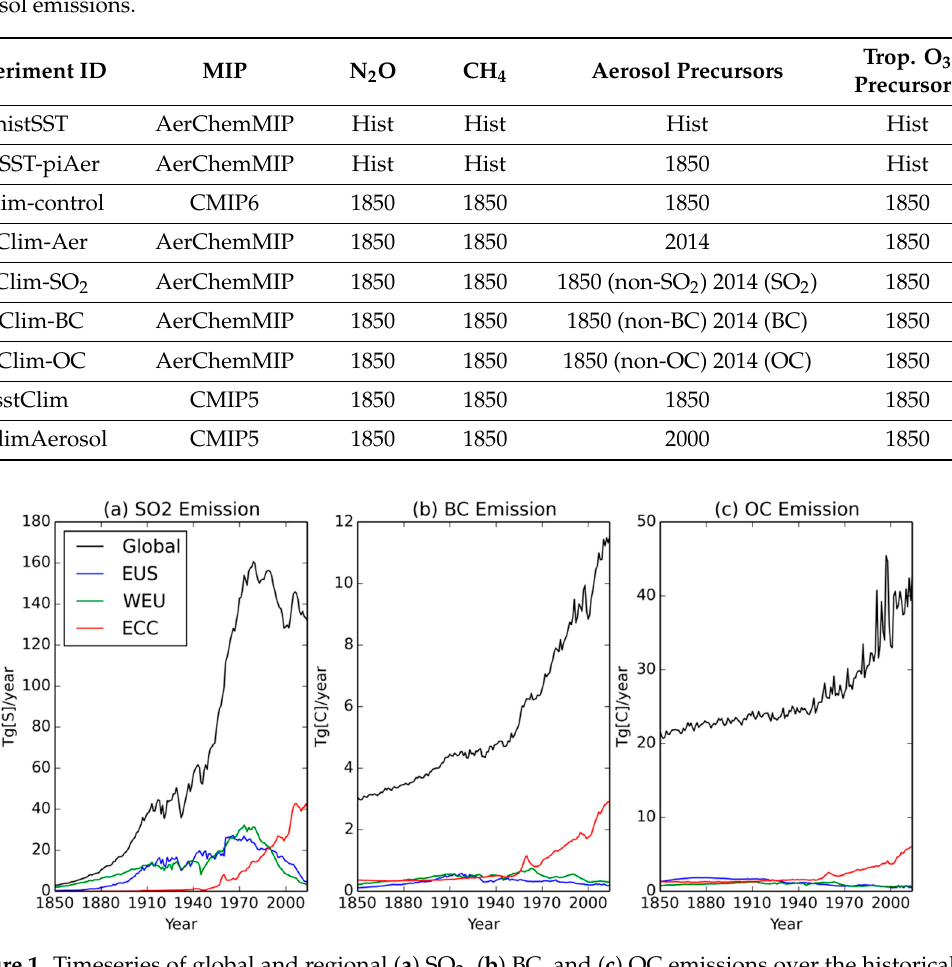
Figure 1. Timeseries of global and regional ( a ) SO 2 , ( b ) BC, and ( c ) OC emissions over the historical period (1850–2014).